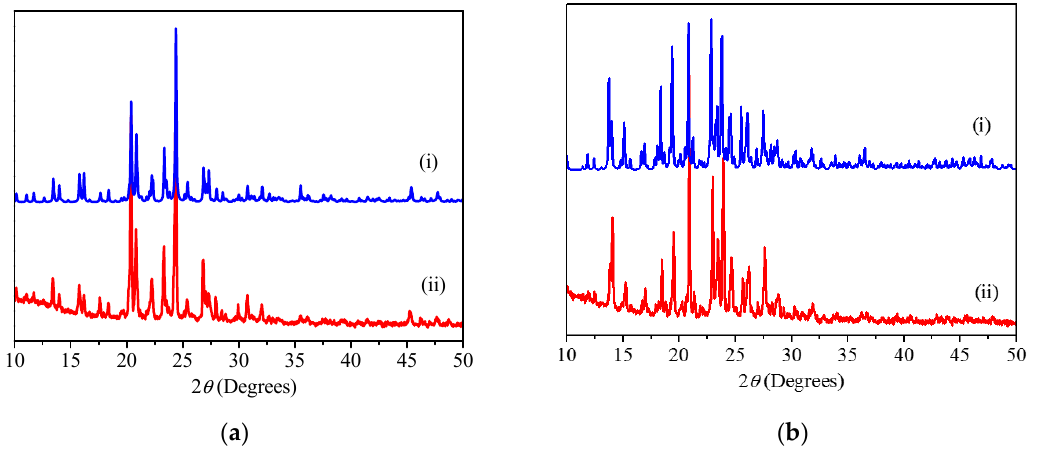
Figure 5. Simulated and experimental powder XRD patterns of 1 ( a ) and 2 ( b ): (i) calculated from single crystal structural analysis (blue line) and (ii) experimental (red line).